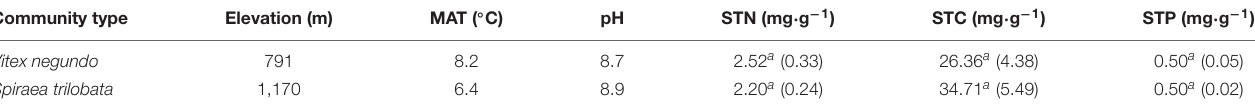
TABLE 1 | Elevation, mean annual temperature (MAT), soil total C (STC), soil total N (STN), and soil total P (STP) of the experimental sites (from Zhang et al., 2015). Community